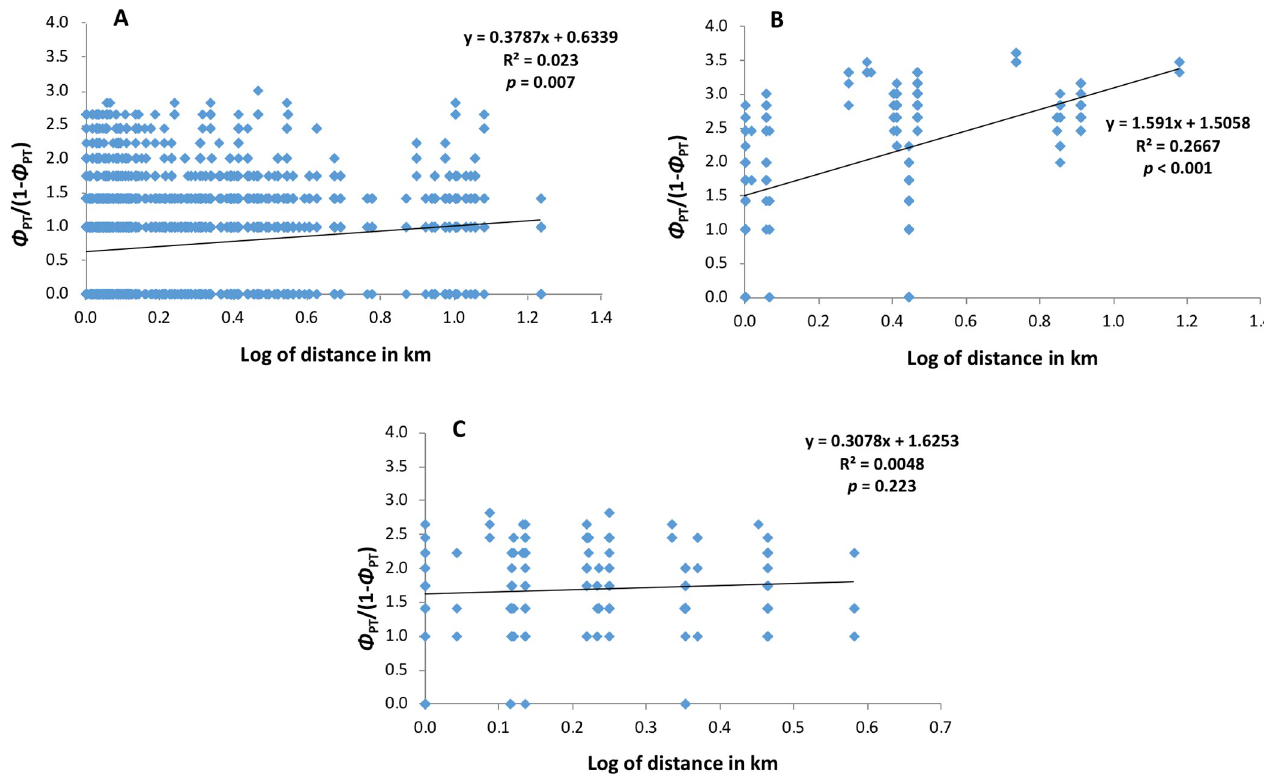
Fig 5. Regression of pairwise genetic distances and geographic distances of isolates from: A. cotton; B. soybean; and C. tomato in the southeastern US. The p -values are based on 1,000 permutations. The tomato population includes isolates from pepper, cucumber, and mandevilla.